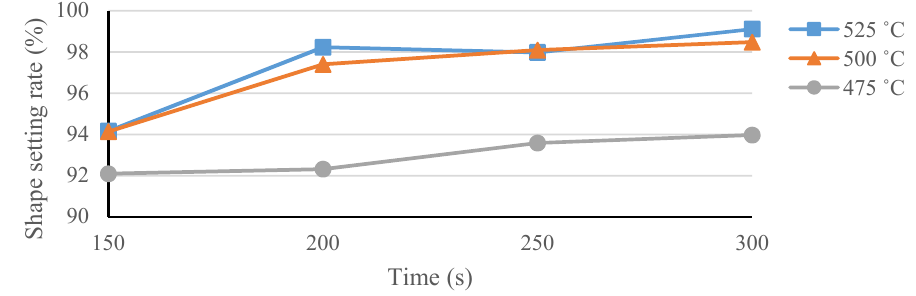
Figure 14. Shape setting rate of the spherical occlusion device. Table 2. Experimental data of the measured shape setting rate.